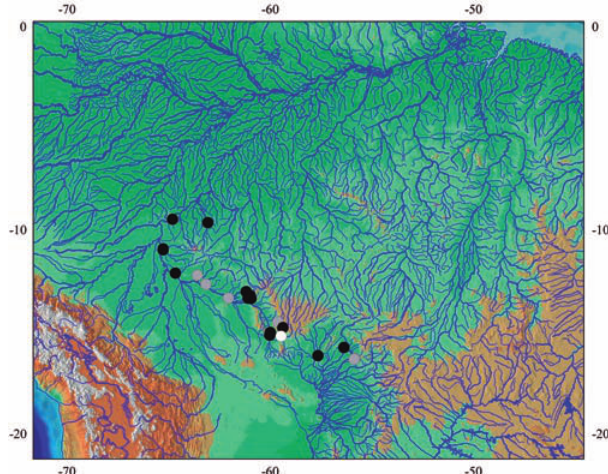
Fig. 3. Map of northern South America showing distribution of Hemigrammus machadoi . The white circle represents the type locality, black circles represent the paratypes localities, and the gray circles represent the non-types